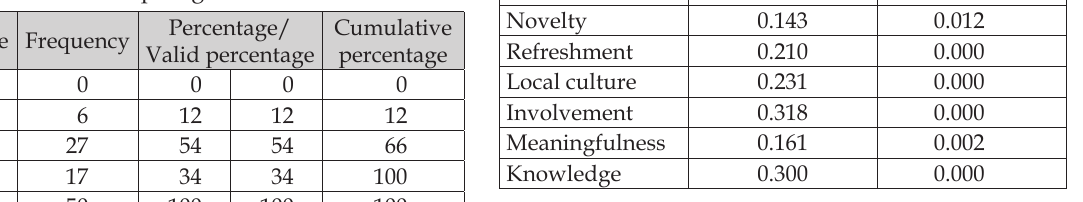
Table 3. Sample age distribution.